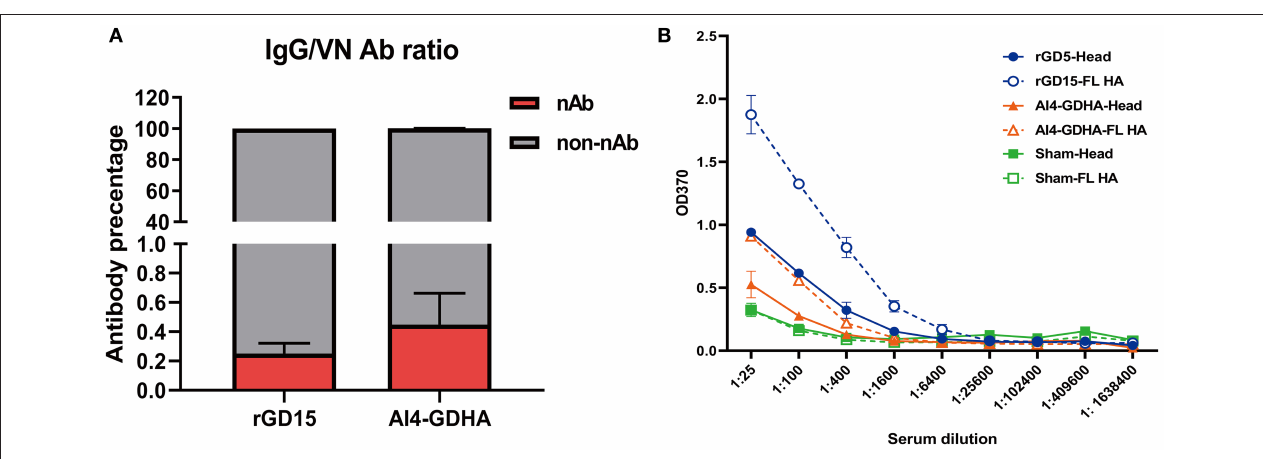
FIGURE 3 | Ratio of nAb and non-nAb in immune sera and the HA region recognized by the sera. (A) Ratio of nAb and non-nAb in sera was calculated. (B) IgG titers against the HA and HA1 proteins. FL, the full-length HA protein; Head, the HA1 protein; NC, the sham control serum. Serum samples from each immunized chicken were pooled and